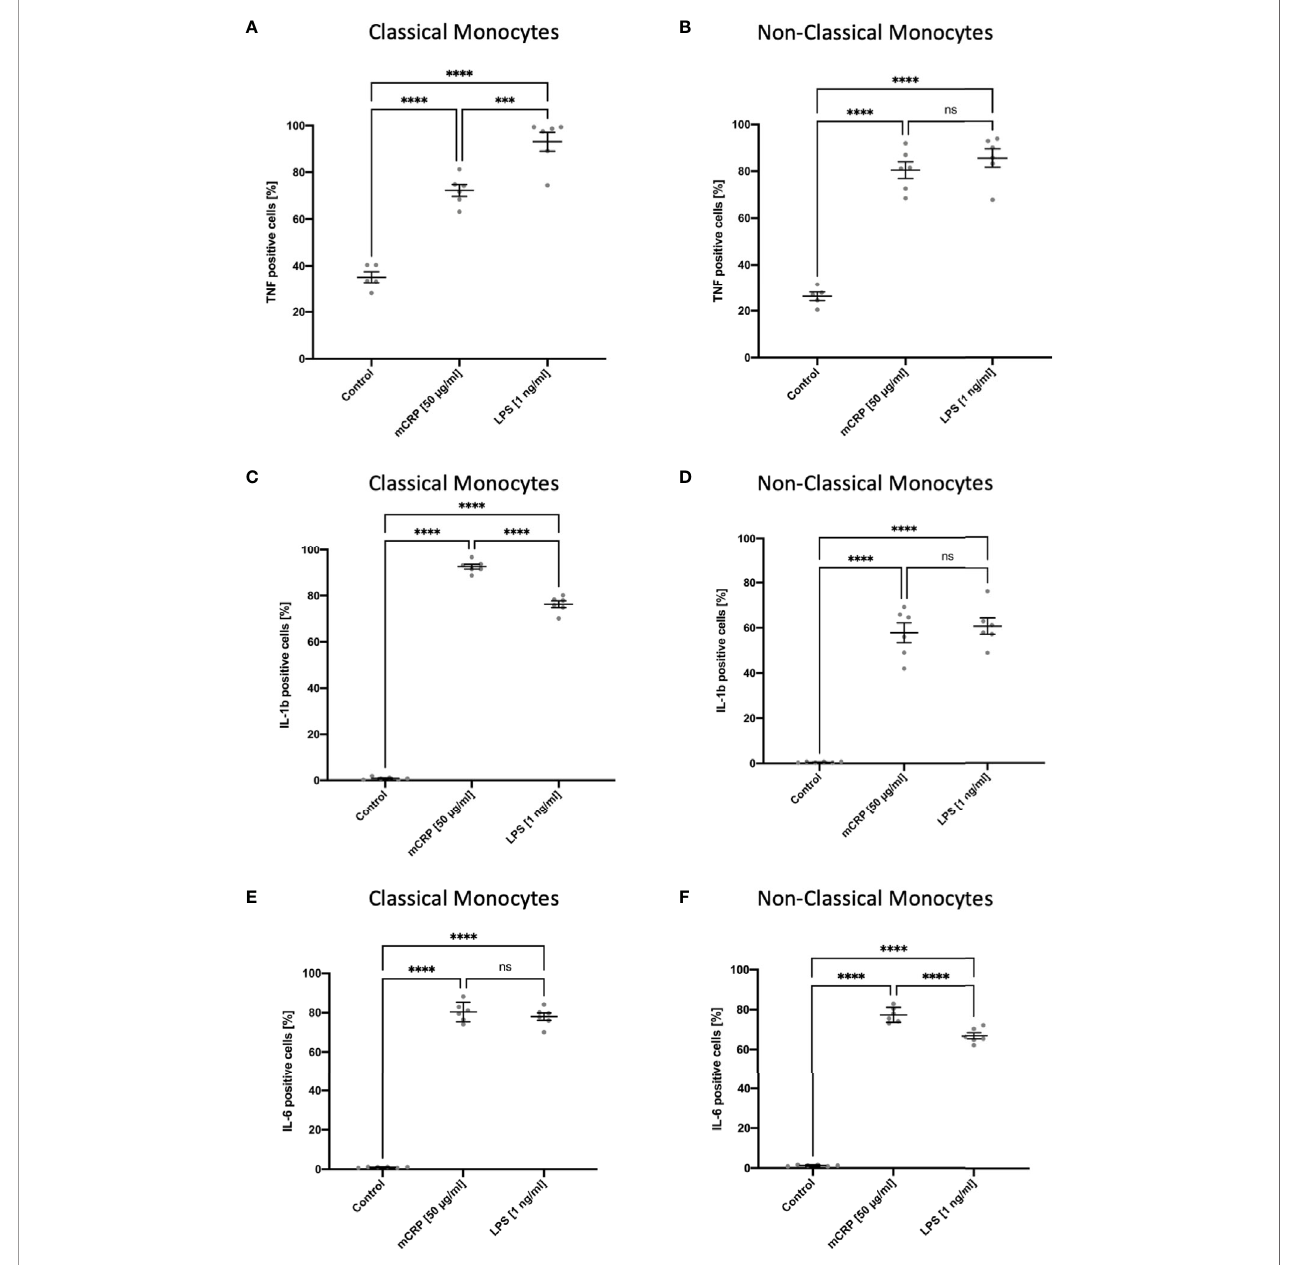
FIGURE 4 | Subset-speci fi c assessment of intracellular TNF, IL1b, and IL6 production in circulating blood monocytes after incubation in whole blood for six hours with PBS (control), mCRP, and LPS. Brefeldin A was used to inhibit the protein transport from the endoplasmic reticulum to the Golgi complex. Both monocyte subsets showed a rapid increase of TNF-positive monocytes in a subset-speci fi c manner upon LPS and mCRP stimulation with non-classicals monocytes being the main source of TNF (A, B) . For IL1b, a subset-speci fi c upregulation of intracellular production, predominantly in classical monocytes, was found both following mCRP and LPS stimulation. Within classical monocytes, IL1b production was signi fi cantly higher upon mCRP stimulation (C, D) . In contrast, the intracellular upregulation of IL6 production markedly increased upon both reagents and showed a subset-speci fi c pattern only following LPS incubation (E, F) . ns, not signi fi cant; ***p < 0.001; ****p < cell lysis. Since surface expression markers on monocytes can change depending on their activation state, it is of utmost importance to apply robust fl ow cytometry gating techniques to detect monocyte subpopulation under various conditions. separated cell activation, cell fi xation, and subsequent red blood